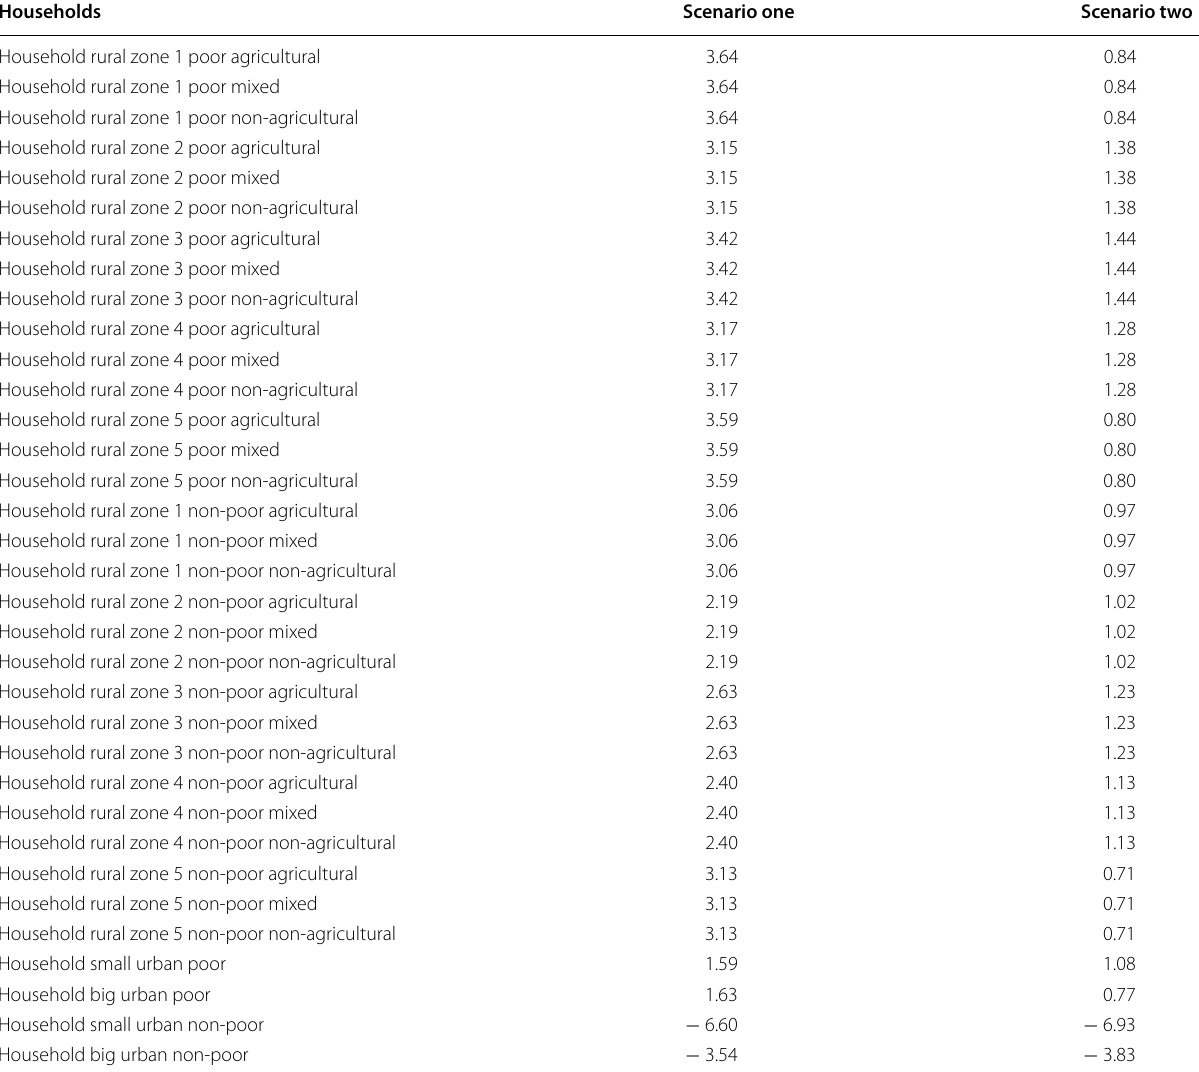
Table 6 Simulated changes (percentage) in household welfare (EV/base income)